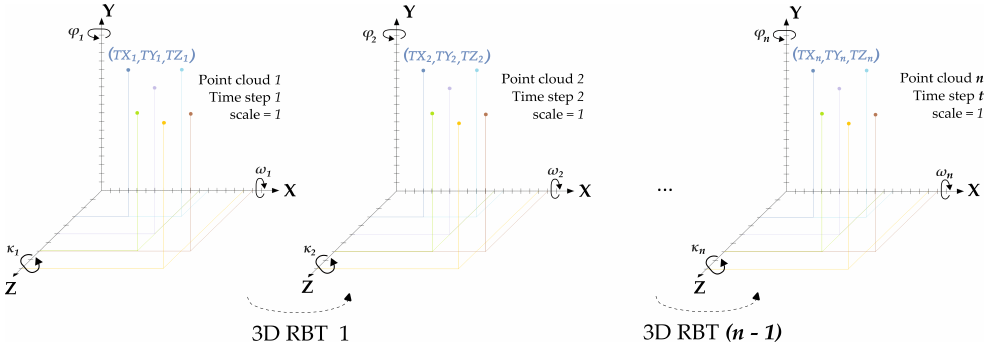
Figure 6. Rigid-body transformations (RBT): The transformation n is performed for the point clouds n and ( n + 1 )